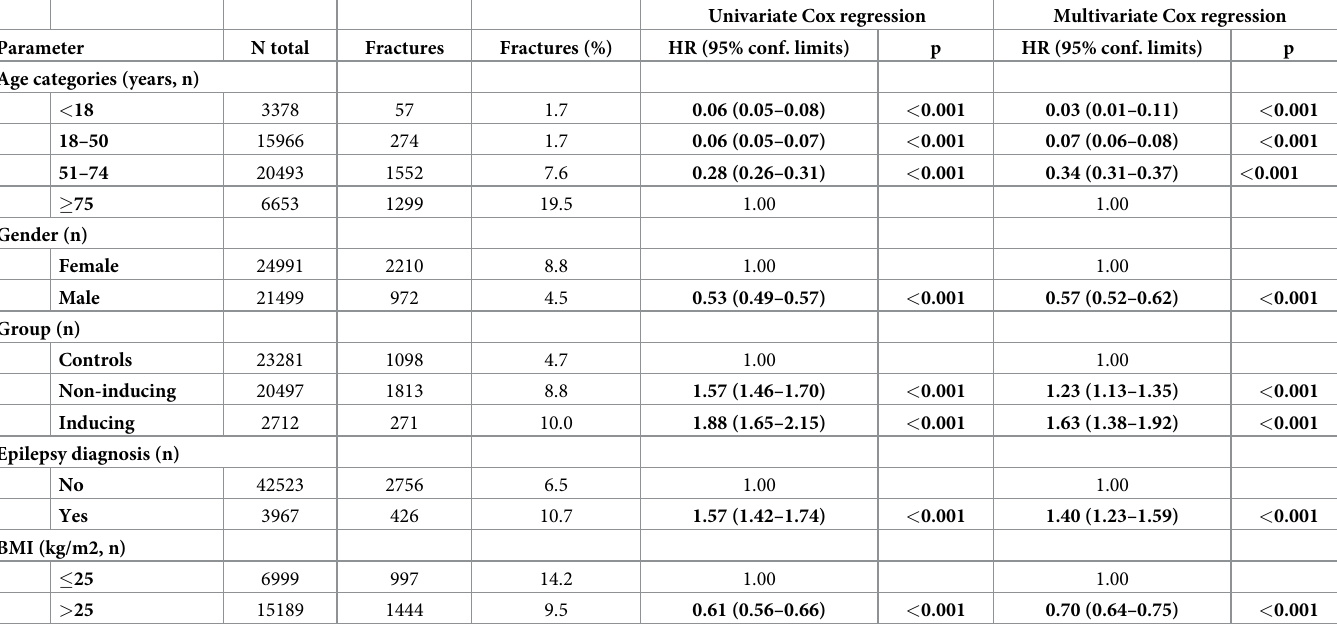
tion in the EHR. The hazard rate ratios of LEFs were analyzed with regards to five previously suggested risk factors; age, gender, type of AED, epilepsy diagnosis and BMI (Table 2). In the univariate Cox regression analysis, the statistical differences in individual risk factors are dis- played. Advanced age, female gender, having been prescribed an AED, having a registered epi- lepsy diagnosis and a low BMI all involved higher LEF rates. In the multivariate Cox regression analysis, the five risk factors’ relative importance is presented, taking the variation of the risk factors between groups into account. All five risk factors remained statistically sig- nificant in the multivariate regression analysis. Long term medication ( � 5 years) was also incorporated in the model but was not found statistically significant, and did not alter the regression coefficients included in the index significantly. Patients prescribed CYP enzyme- inducing AEDs had a hazard rate ratio for LEF of 1.63 (1.38 to 1.92) compared to controls, while patients prescribed non-inducing AEDs had a ratio of 1.23 (1.13 to 1.35) compared to controls. Patients prescribed AEDs for epilepsy had a ratio for LEF of 1.40 (1.23 to 1.59) com- pared to those prescribed AED for non-epileptic conditions. In Figs 2 and 3, the differences in Table 2. Results from Cox proportional hazard regression regarding risks for low energy fractures, analysed for the total